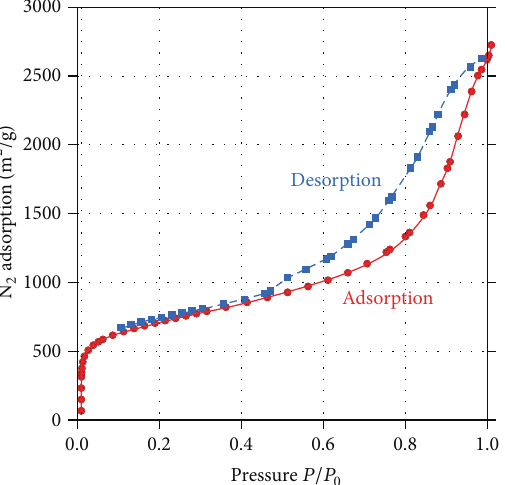
Figure 5: Nitrogen absorption-desorption equilibrium curves for the amorphous carbon prepared in this work. The sample was preannealed at 100 ∘ C for 6h in vacuum and was analyzed at the liquid nitrogen temperature of 77